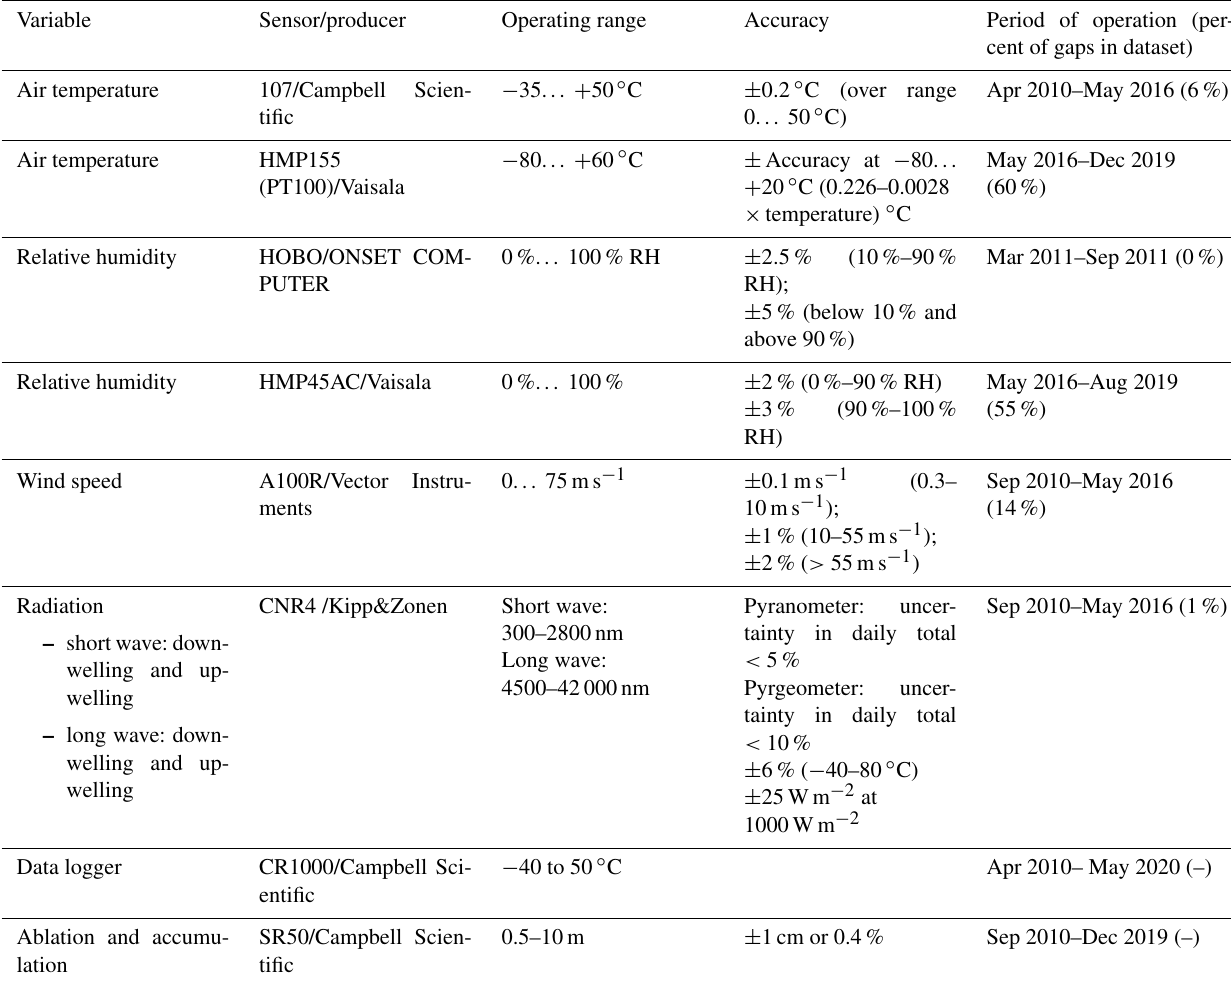
Table 1. Automatic weather station (AWS) sensors specification (Werenskioldbreen, Svalbard). All sensors were set in the spring so that they were about 1.5m above the snow surface, and height has been varied during the